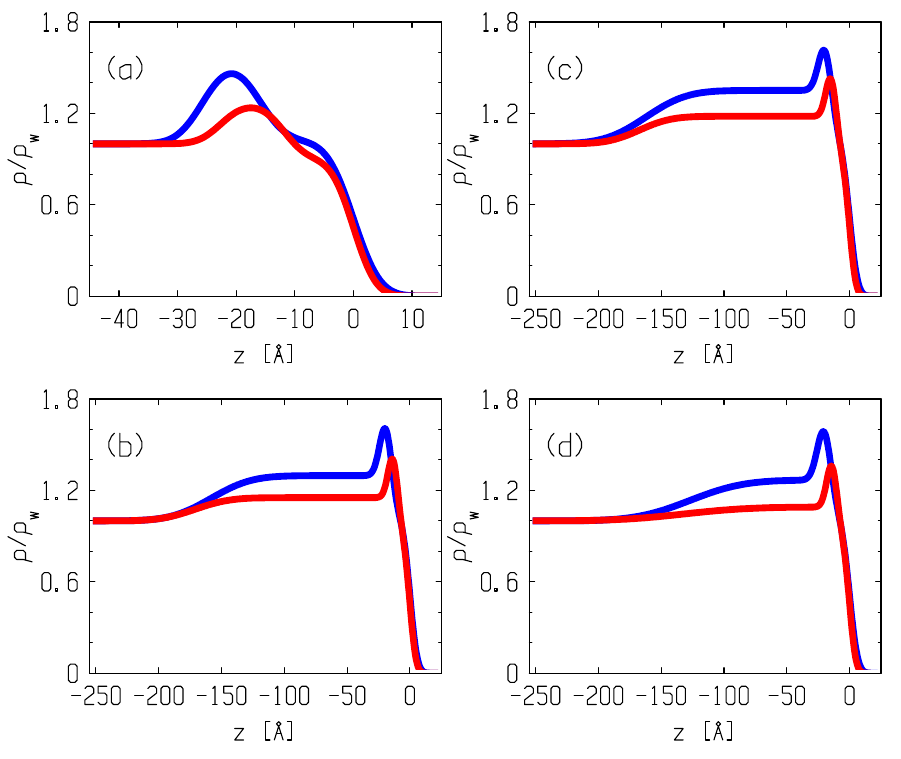
Figure 5. Surface–normal electron density profiles, ρ (z), normalized to the electron density in water under normal conditions, ρ w = 0.333 e − / Å 3 . Blue lines are for films at the condensed LC state of the lipid monolayer near the collapse, A ≈ 40 Å 2 . Red lines are for films at the liquid LE state of lipids below the phase transition at a value of area per molecule, A ≈ 70 Å 2 . Panels correspond to the surface of the 10 mM KCl water subphase ( a ) and water solutions of PL-5 ( b ), PL-12 ( c ), and PL-200 ( d ), respectively. Table 2. Fitting parameters for fits with Equation (1) to the X-ray reflectivity from the DMPS monolayers with the area per lipid molecule, A. σ 0 is the width of the acyl group layer–air interface. L 1 and L 2 are the thicknesses of the acyl group layer with the density ρ 1 and the headgroup regions with the density ρ 2 , respectively. L 3 and ρ 3 are the thickness and electron density of the polymer layer, correspondingly. σ 3 is the roughness parameter for the water–polymer layer interface. n is the estimated number of hydrated water molecules per lipid molecule obtained from the two-layer model for the lipid layer. The electron densities are normalized to the electron concentration in water ´ under normal conditions, ρ w = 0.333 e − / Å 3 . The error bars were estimated utilizing the conventional χ 2 criteria at a confidence level of